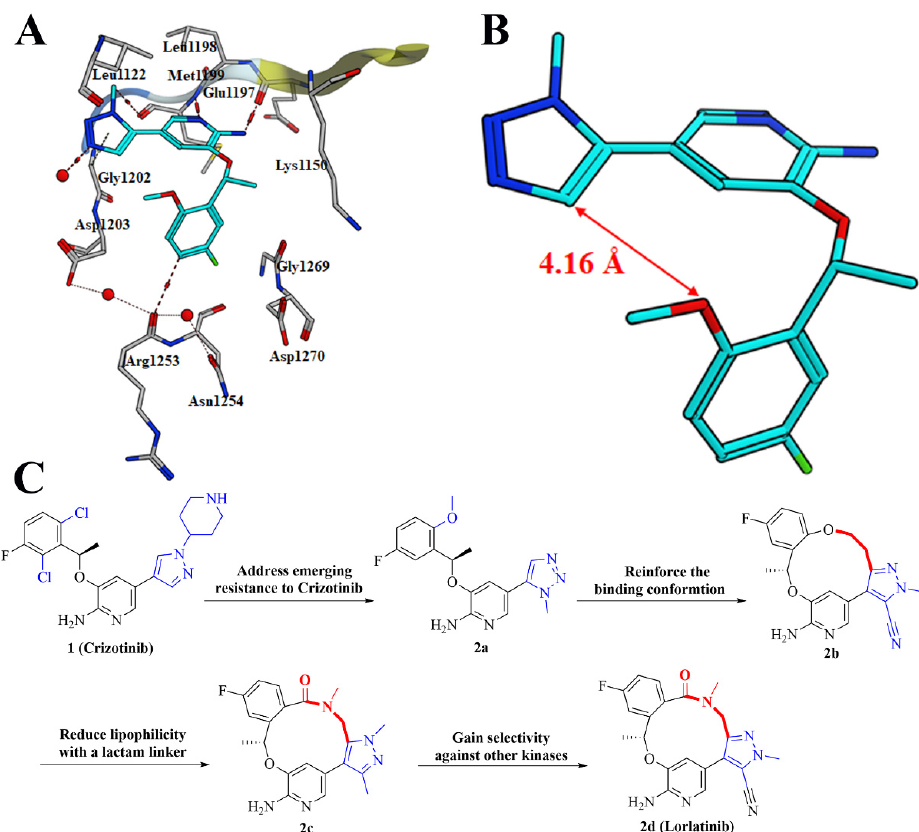
Figure 1. ( A ) Cocrystal structure of the wild-type kinase domain of ALK with 2a (PDB: 4CNH). ( B ) Molecular 3D structure of compound 2a . ( C ) Structural modification of macrocyclic ALK inhibitors.